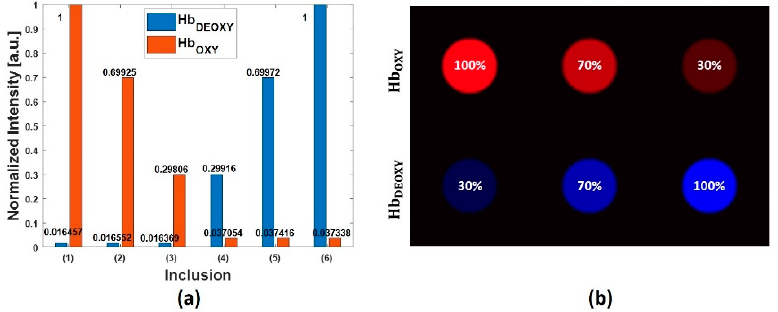
Figure 4. ( a ) Quantitative evaluation of the prominent source components (oxyhemoglobin and deoxyhemoglobin), per each circular region of the synthetic phantom. ( b ) Overlapped abundance maps of oxyhemoglobin and deoxyhemoglobin.